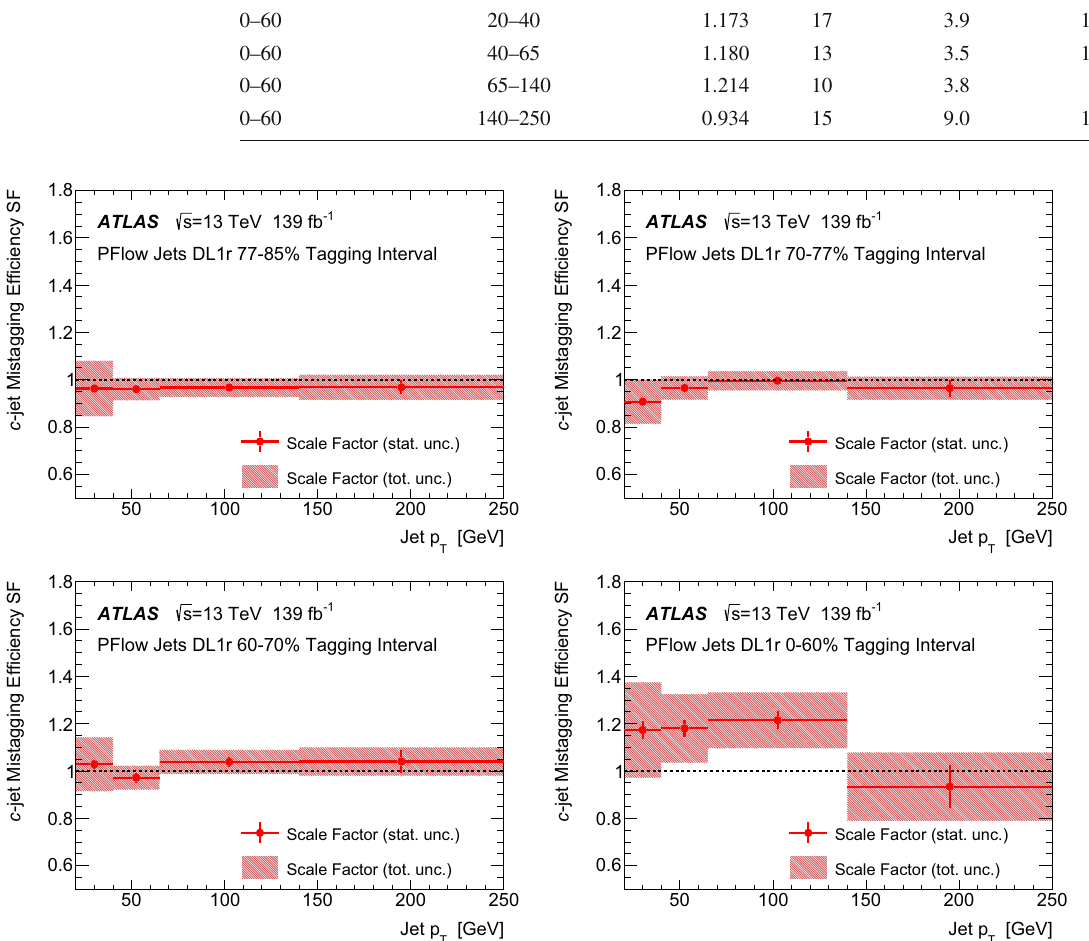
Fig. 3 The c -jet pseudo-continuous mistagging efficiency scale factors for particle-flow jets shown as a function of jet p T for four tagging intervals. The scale factors are shown for the Pythia 8+ EvtGen fragmentation